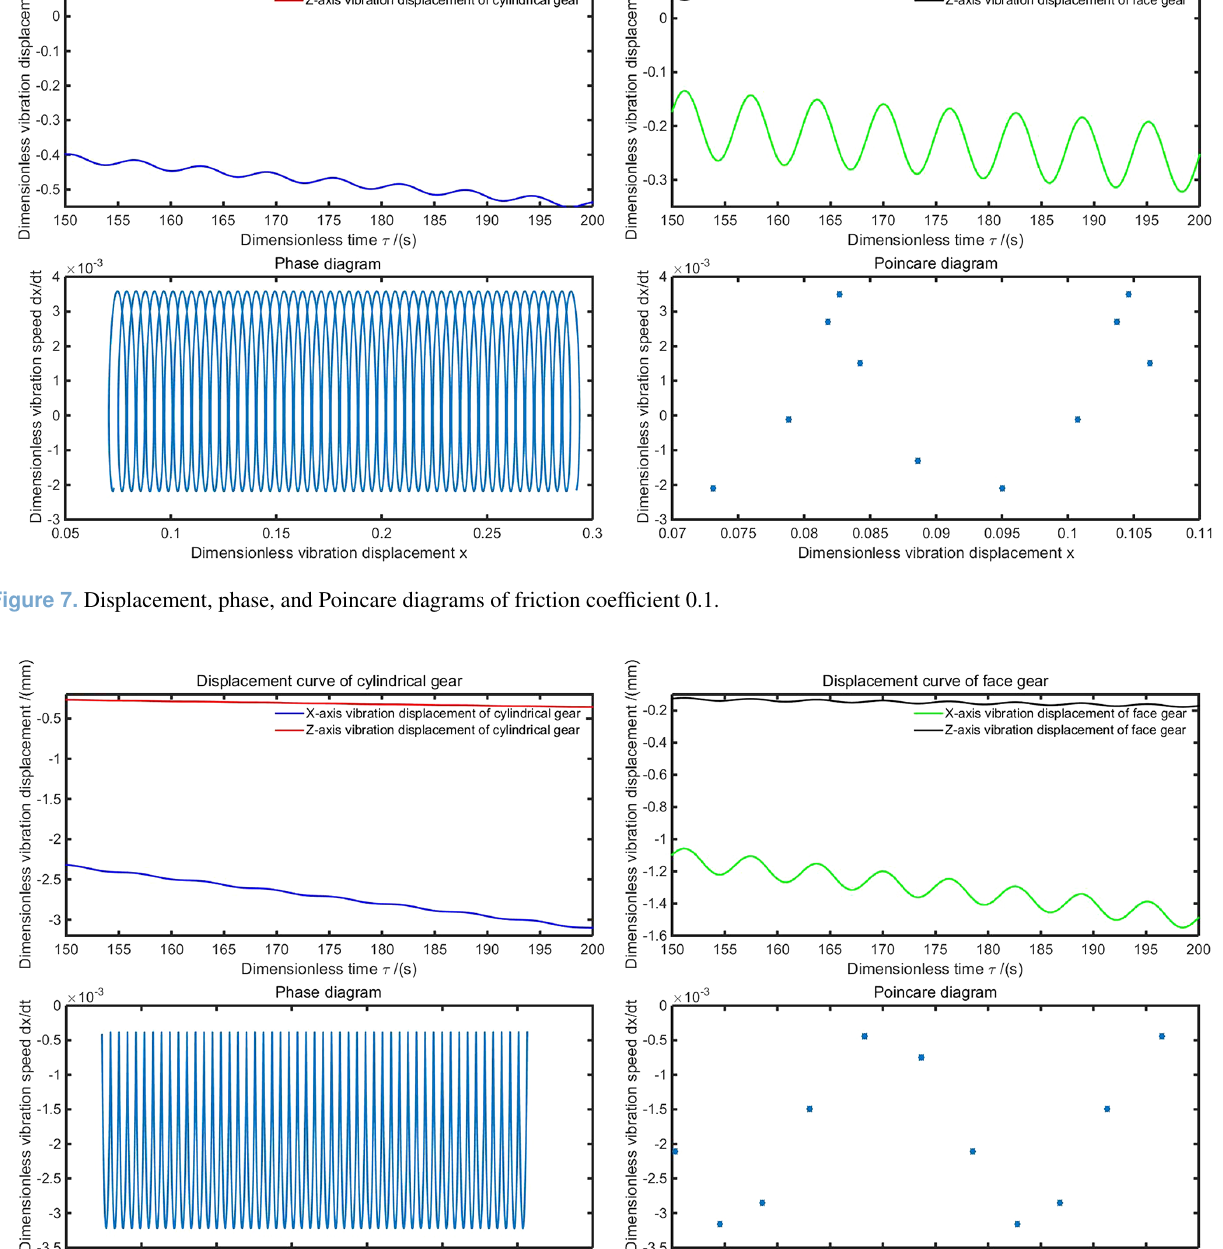
The integrated meshing stiffness is directly related to the input torque and the load deformation. As per Figs. 10, 11 and 12, the vibration displacement amplitude increased with the reduction of the integrated meshing stiffness. Owing to the frictional damping, the degree of vibration displacement